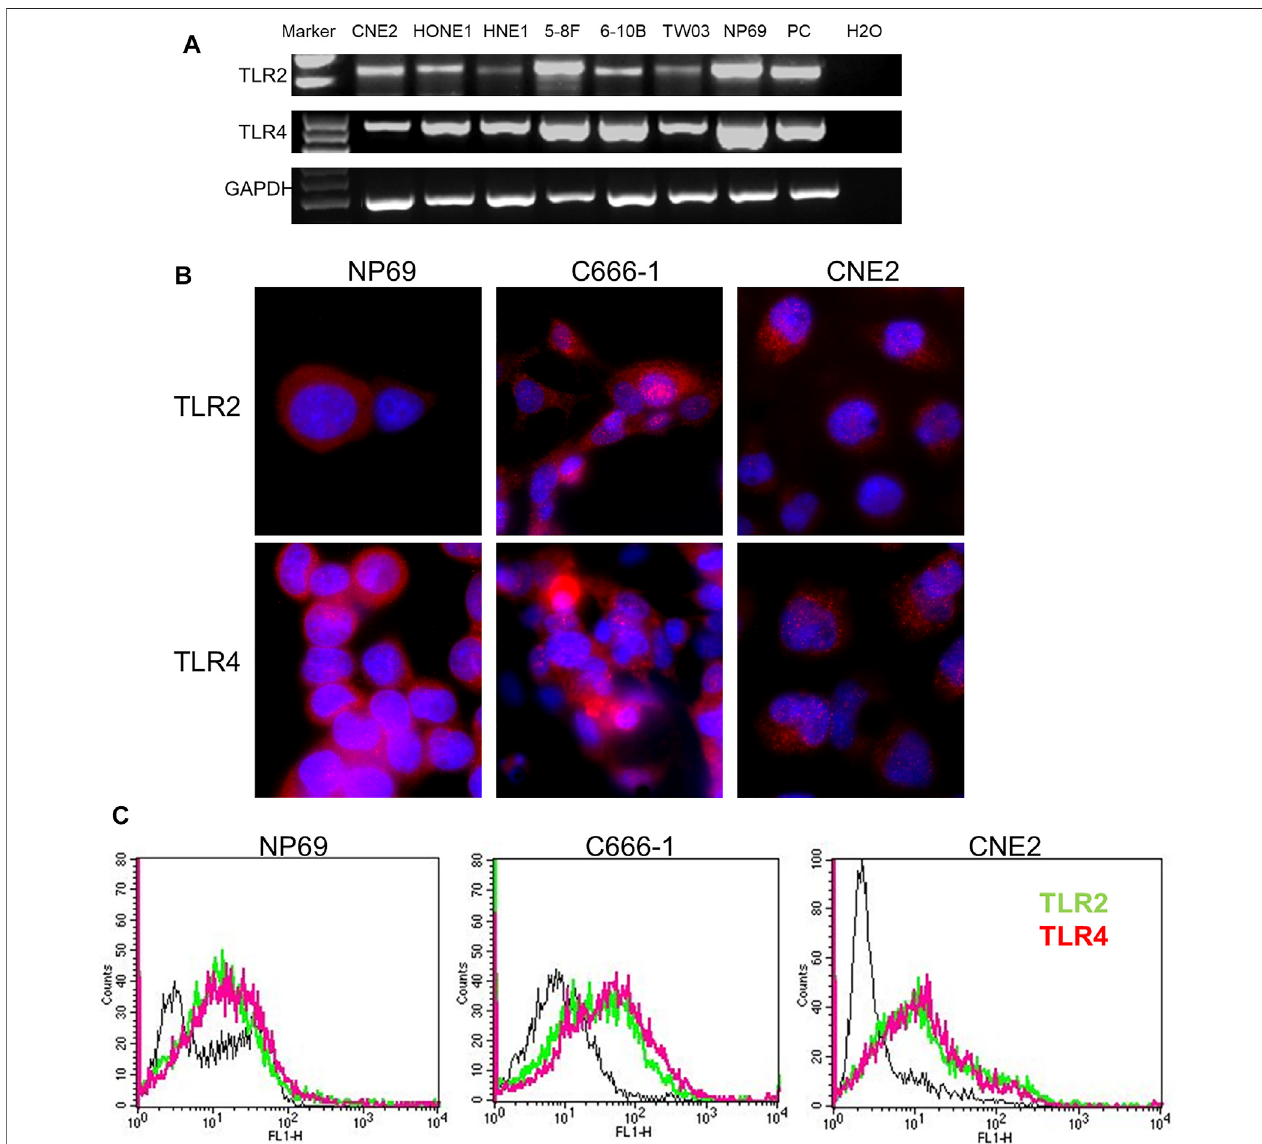
FIGURE 2 | Expression of TLR2 and TLR4 in NNE and NPC cells. (A) RT-PCR analysis of TLR2 and TLR4 mRNA expression. (B) Immuno fl uorescence analysis of TLR2 and TLR4 protein expression. (C) Flow cytometry analysis of cell surface localization of TLR2 and TLR4.